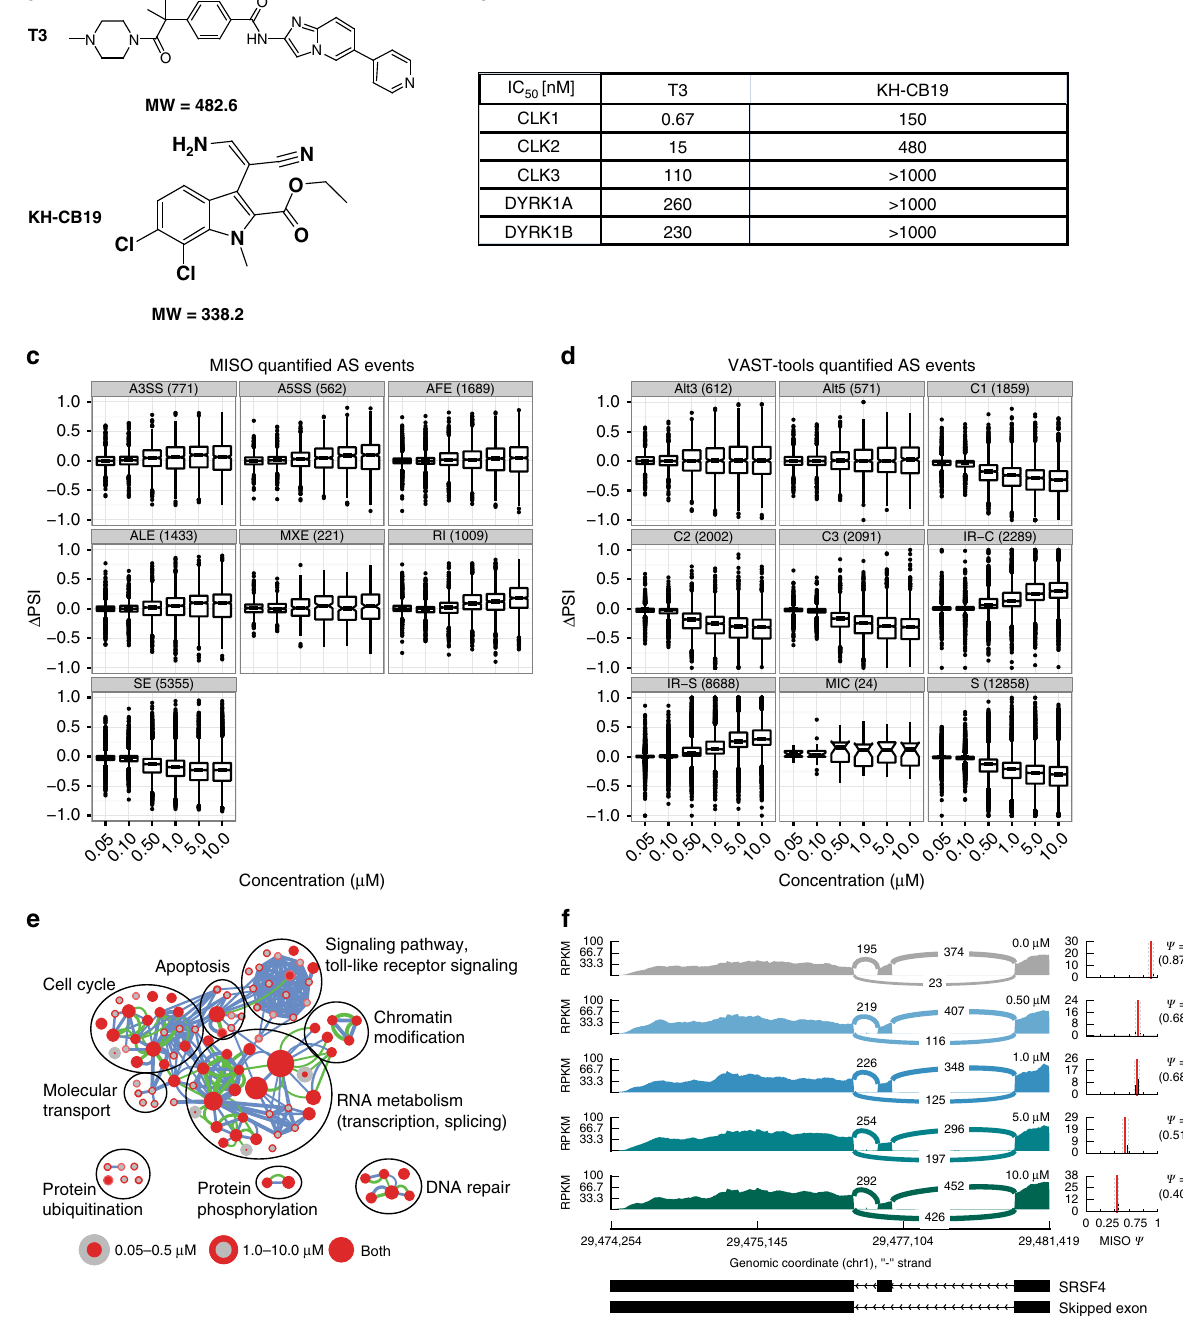
Fig. 1 AS responses to T3 analyzed by event type and biological enrichment. a Chemical structure of “ T3 ” and KH-CB19. b Inhibition spectrum of the compounds for CLK1, CLK2, CLK3, DYRK1A, and DYRK1B (1 mM of ATP was used for CLK1, CLK2, CLK3, DYRK1A, and DYRK1B kinase). c MISO AS event type Δ PSI distributions across CLK inhibitor concentration for the HCT116 unstranded RNA-Seq data set. Horizontal axis categories are concentrations of T3. SE, RI, A5SS, and A3SS event classes are as described in the main text; AFE: alternative fi rst exon, ALE: alternative last exon, MXE: mutually exclusive exon. Event counts in parentheses. d VAST-tools AS event type Δ PSI distributions across CLK inhibitor concentration for the HCT116 unstranded RNA-Seq data set. Horizontal axis categories are concentrations of T3. VAST-tools event types are: S, C1, C2, C3: SE with increasing complexity, MIC: skipped microexons, IR-S: RI not overlapping another annotated event, IR-C: RI overlapping another annotated event, Alt3: alternative acceptor site, Alt5: alternative donor site. Event counts in parentheses. e BP enrichment map for differentially spliced genes in the HCT116 unstranded RNA-Seq data set. Each node represents a GO BP gene set. Node cores are colored red when that gene set is enriched among genes differentially spliced in the 0.05 – 0.5 µ M samples, and the outer ring is colored red when that gene set is enriched in the 1.0 – 10.0 µ M samples. Nodes present in both are solid colored. Edge thickness indicates the level of overlap between two gene sets, considering the set of differentially spliced genes in the 0.05 – 0.5 µ M ( green edges ) or 1.0 – 10.0 µ M ( blue edges ) samples. f Sashimi style plot 62 of exon skipping events associated with the SRSF4 gene. RPKM values are displayed as 0 – 100 along the vertical axis and genome coordinates (bp) along the horizontal axis . Each strip represents increasing T3 concentration, value displayed on the right. The number of events represented by each splice event are inserted in the center of the curved lines. Right of the main plot, MISO PSI posterior